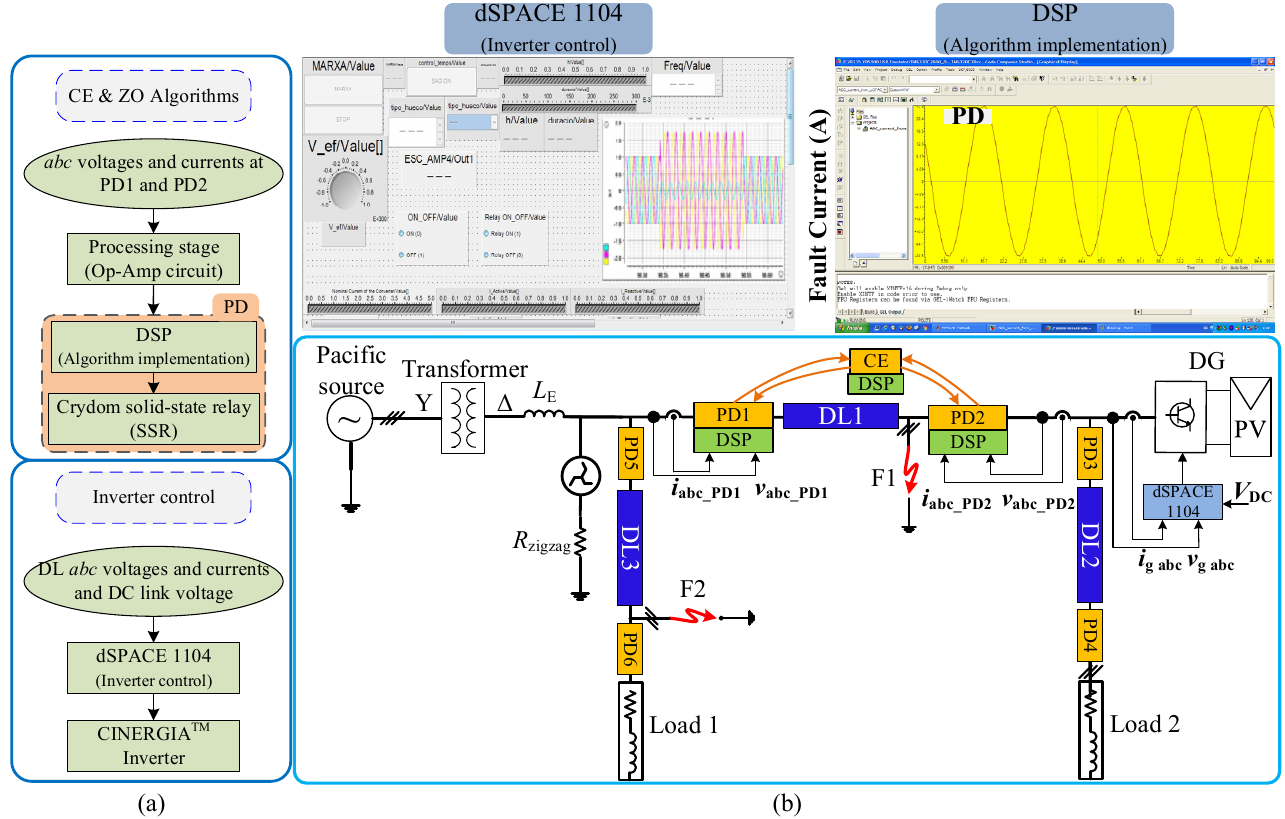
Figure 8. The procedure of the experimental verification: ( a ) Proposed algorithms concept diagram; ( b ) analyzed grid.